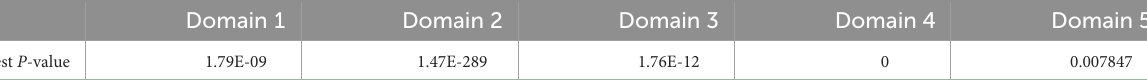
TABLE 3 P -value of one-sided proportion test on five domains.